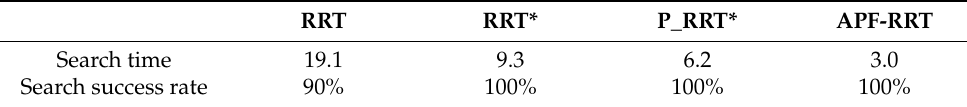
Table 6. Search time and search success rate of different